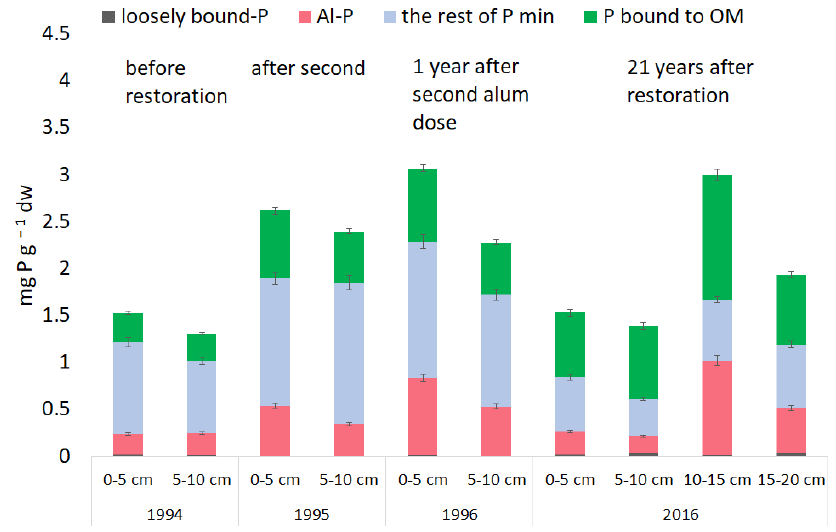
Figure 3. The amounts of selected P fractions (mean values ± SD) in the bottom sediment of Starodworskie Lake in 1994, 1995, 1996 and 2016. Bars’ heights represent total amount of element.